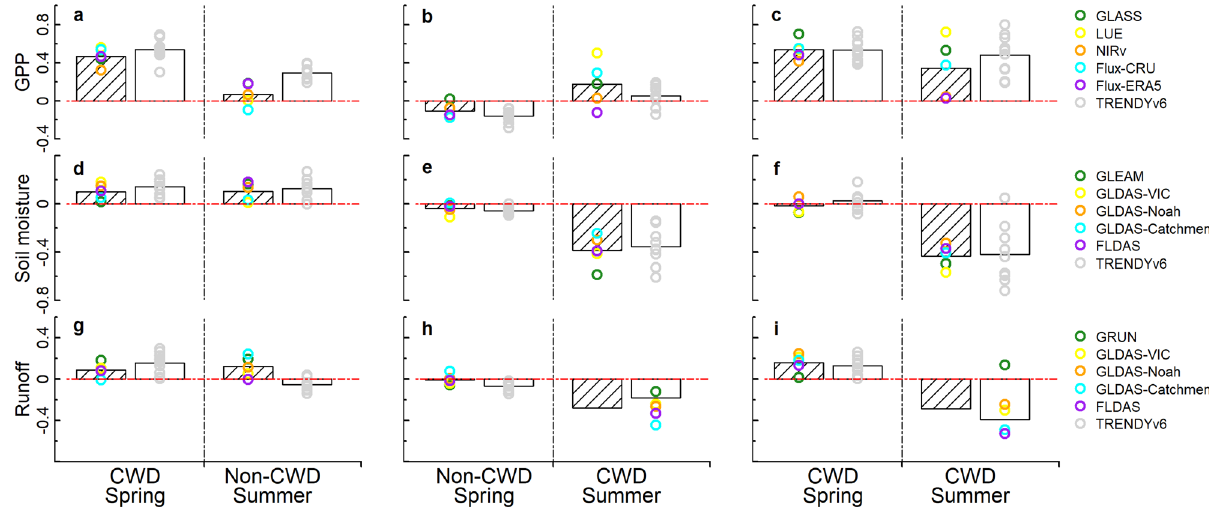
Fig. 3 Seasonal evolution of vegetation productivity and hydrological variables during CWD events in high latitudes (>50°N). a – c The average standardized anomalies (z-score) of GPP during CWD spring but subsequent non-CWD summer ( a ), non-CWD spring but subsequent CWD summer ( b ), and consecutive CWD spring and summer ( c ) for areas in Fig. 2a where summer vegetation responds positively ( r ≥ 0.22) to spring CWD climate conditions. d – f The same as a – c , but for soil moisture. g – i The same as a – c , but for runoff. The bar plots with dash lines (without dash line) indicate the average anomalies of multiple observation-based (model-based) products, and the circles indicate the average anomalies of each product. GLASS, LUE, NIRv, Flux-CRU, and Flux-ERA5 are observation-based GPP products, while model simulations are taken from TRENDYv6. GLEAM is observation-based soil moisture. GRUN represents observation-based runoff. GLDAS-VIC, GLDAS-Noah, GLDAS-Catchment, and FLDAS indicate assimilatory soil moisture and runoff that incorporate satellite- and ground-based observational